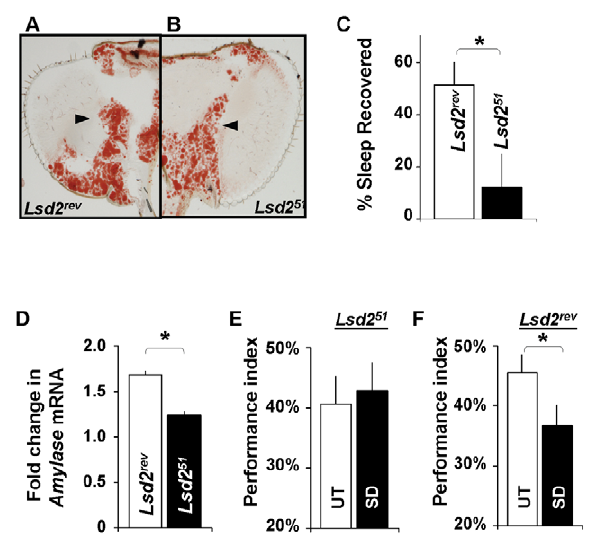
Figure 5. Lsd2 mutant flies mimic the phenotypes seen in starved cyc 01 flies. (A) A representative section of Lsd2 rev head stained with Oil Red O. Head fat bodies are denoted by arrowheads. (B) A representative section of Lsd2 51 head stained with Oil Red O. (C) Lsd2 51 mutants ( n =22) do not exhibit a homeostatic response following 12 h of sleep deprivation while their genetic background control, Lsd2 rev ( n =41), do exhibit a sleep rebound following sleep loss. * p =0.012; Student’s t test. (D) Amylase mRNA levels of Lsd2 51 mutants are significantly lower than genetic background controls, Lsd rev , following 12 h of sleep deprivation. Data are presented as percentage from untreated siblings (2 replicates of n =20 heads/group). * p , .05, Student’s t test. (E) Learning is not impaired in Lsd2 51 mutants ( n =7) following 12 h of sleep deprivation compared to untreated controls ( n =8); p =0.37 Student’s t test. (F) Learning is impaired in Lsd2 rev flies ( n =15) following 12 h of sleep deprivation compared to untreated controls ( n =15).* p =0.036 Student’s t